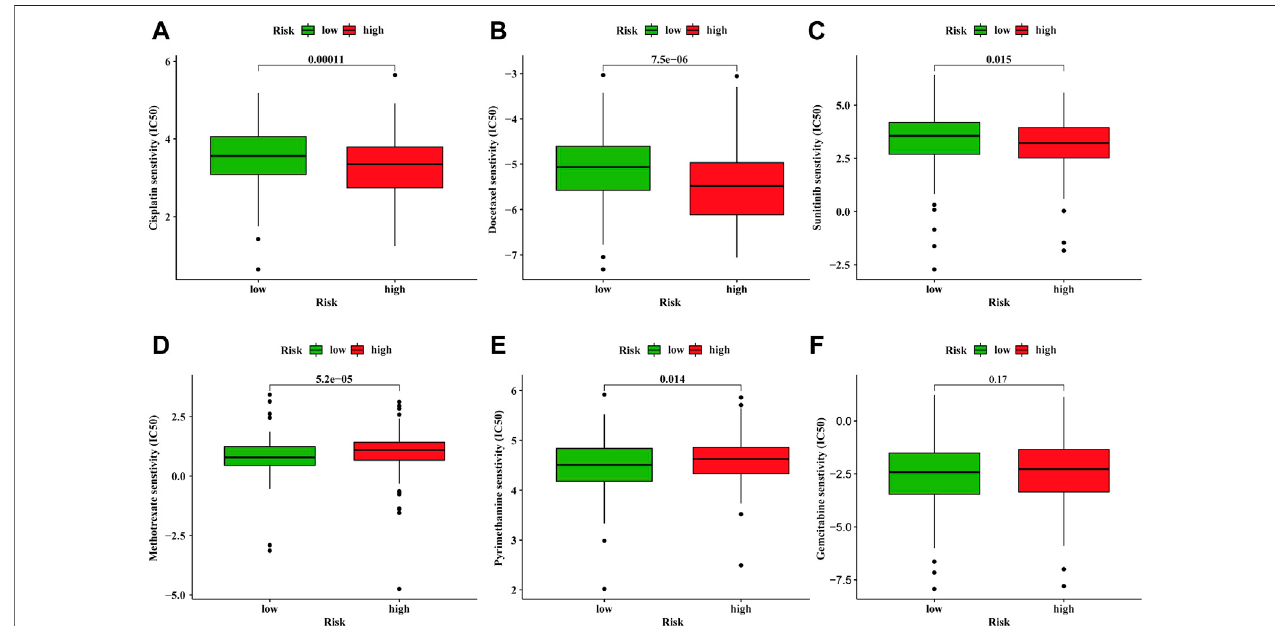
FIGURE 7 | Discrepancy of drug sensitivity between high- and low-risk groups. The IC50 of cisplatin (A) , docetaxel (B) , sunitinib (C) , methotrexate (D) , pyrimethamine (E) , gemcitabine (F) between high- and low-risk groups.